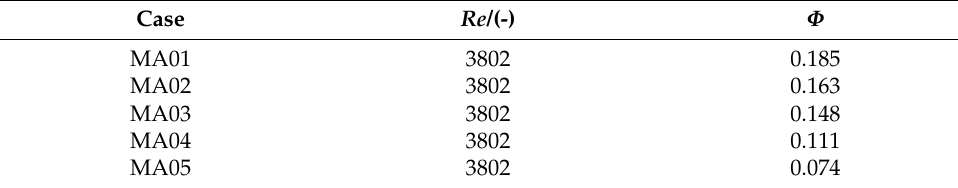
Table 1. Test conditions of the M combustor.